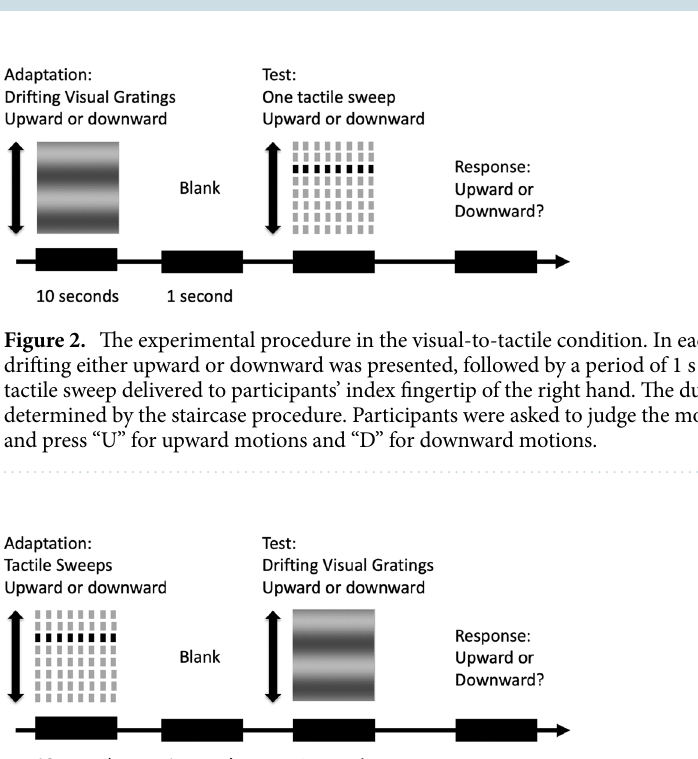
condition, was presented with the same onset and ending time and in the same direction as the tactile sweep. Participants were asked to observe the visual grating, feel the tactile sweeps, and imagine that their index finger was aligned with the fixation point. In the baseline session, participants completed three staircases of drifting gratings by judging whether the grating was moving upward or downward. The grating was the same in parameters as in the visual-to-tactile condition except that the contrast was reduced to 1%. The grating consisted of 5 successive frames, and each frame lasted for 200 ms (1 s in total). The phase jump between two successive frames was manipulated by a 1-down-1-up staircase procedure. A perfect counter-phase of the original grating was defined as 180°; a positive phase jump represented an upward drifting while a negative phase jump represented a downward drifting. The three staircases respectively started from a phase jump of 40°, − 40°, or 0°, with a step size of 4°. The staircase stopped when 20 reversals or 40 trials were reached. Participants were asked to judge the visual motion direction by pressing “U” for “upward” and “D” for “downward.” In the adaptation sessions, participants adapted to tactile sweeps in one direction and then judged the motion direction of a drifting grating. In each trial, participants first received 20 successive tactile sweeps with fixed parameters for a total of 10 s: a single 240 ms sweep consisted of all 8 rows and each row vibrated for 30 ms at 33.3 Hz (i.e., ISO = 30 ms), followed by a 260 ms pause. All 20 tactile sweeps were going in the same direction: either upward or downward. Right after the 20 sweeps was a blank period for 1 s. Then a target drifting grating was presented for 1 s in the center of the screen, which was the same in parameters as in the baseline session. Participants judged the motion direction of the target grating by pressing “U” for “upward” and “D” for “down- ward” motions (Fig. 3). The phase jump of the visual grating always started from 2° and was manipulated by the same 1-down-1-up staircase procedure as in the baseline session. There were two sessions with a ten-minute break in between: one session adapting to upward tactile sweeps and the other adapting to downward sweeps. The order of the two sessions was counterbalanced between participants.